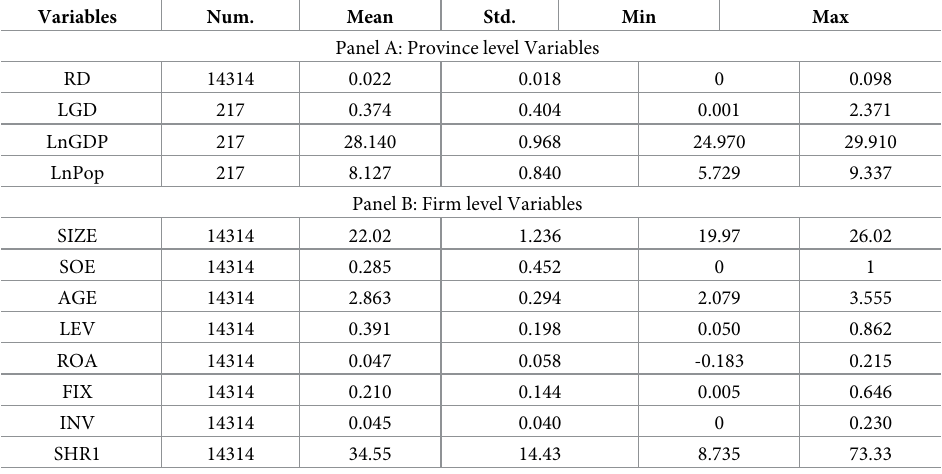
Table 2. Summary statistics of the main